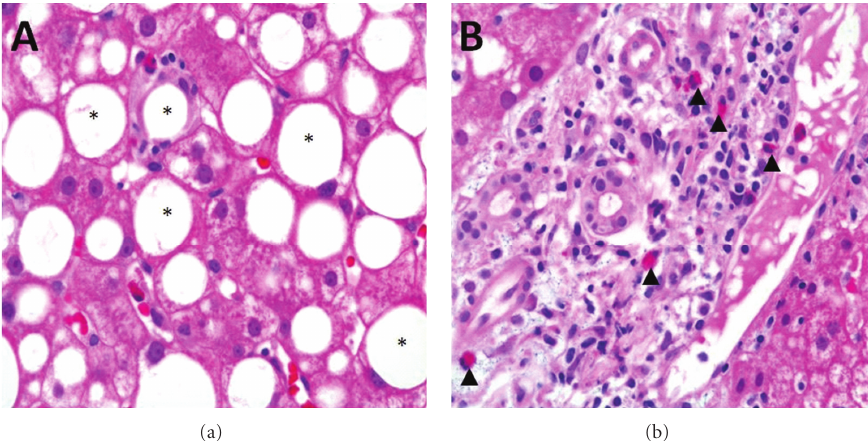
Figure 1: (a) and (b) Representative specimen of the liver biopsy showing a mixture of a rampant steatosis ( ∗ ), a lipogranuloma as a hint to florid steatohepatitis (a) as well as minimal portal field edema, and portal eosinophilic infiltration ( (cid:2) ) suggestive of a medical or toxic injury